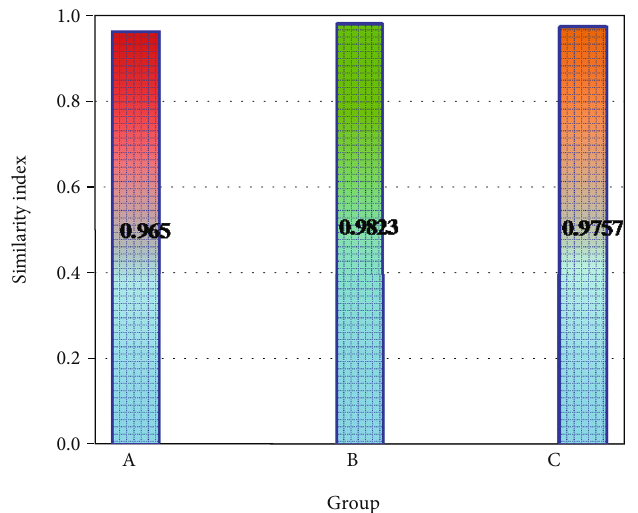
Figure 4: Similarity index of three characteristics of English